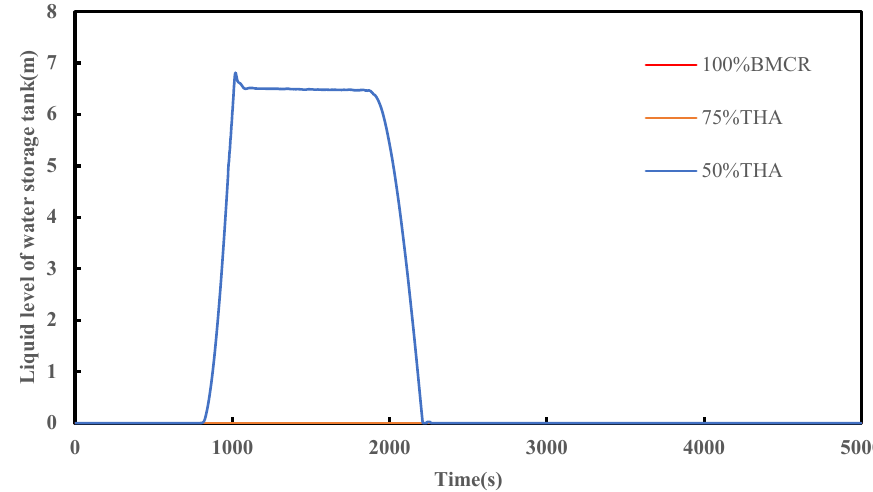
Figure 14. Response of liquid level of water storage during BTT at different conditions.